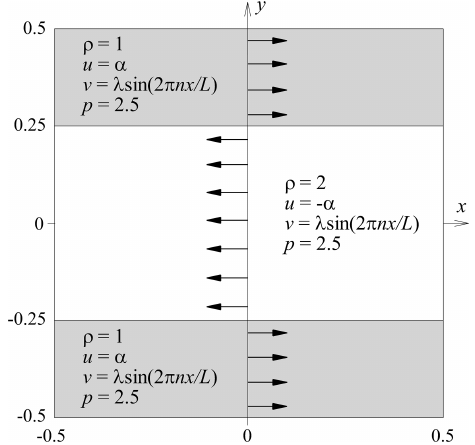
Figure 1. The stratified Kelvin–Helmholtz instability problem in a periodic square box of side length L = 1. Our initial condition reads as a single-mode perturbation to the y -component of the velocity to trigger the instability with n = 2 and the amplitude λ = 0 . 01. We extend this two-dimensional domain along the z direction to per- form our three-dimensional simulations in a triply-periodic domain with size L in each side where we also use an initial perturbation to the z -component of the velocity given by w = λ sin ( 2 πnz/L) .